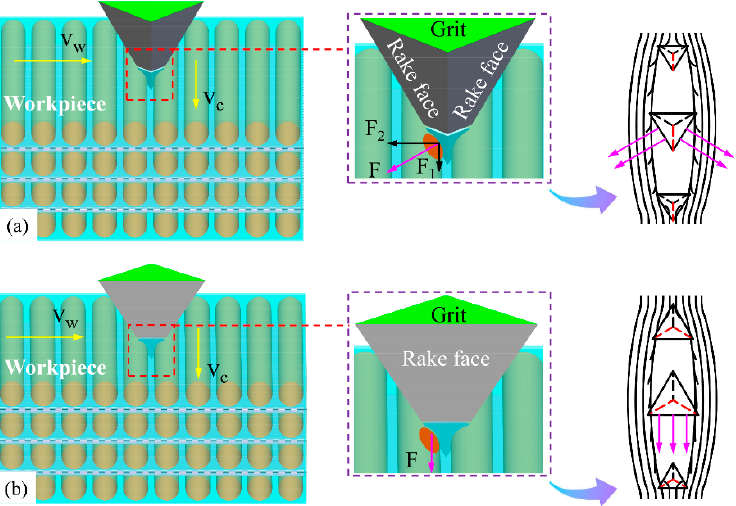
Figure 7. Schematic diagram showing the cutting mechanism for triangular pyramid tools when λ = 0 ° : ( a ) tool with one main cutting edge and two side cutting edges, and ( b ) tool with two main cutting edges.